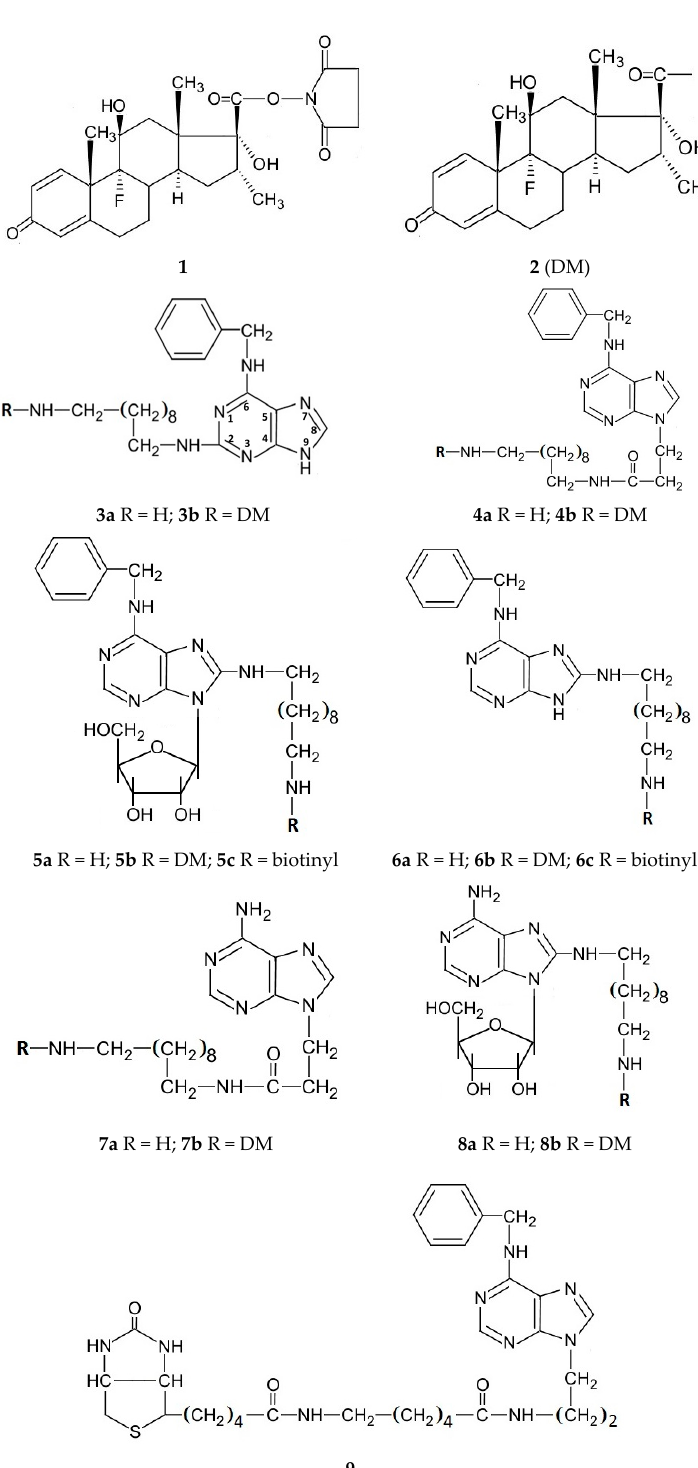
Figure 1. Structures of compounds used and synthesised in this study.